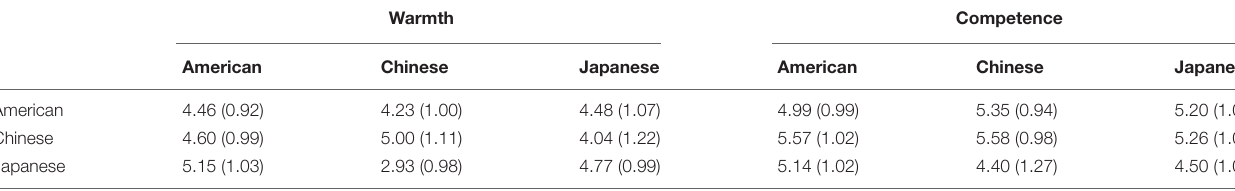
TABLE 2 | National stereotypes reported by American, Chinese, and Japanese participants.